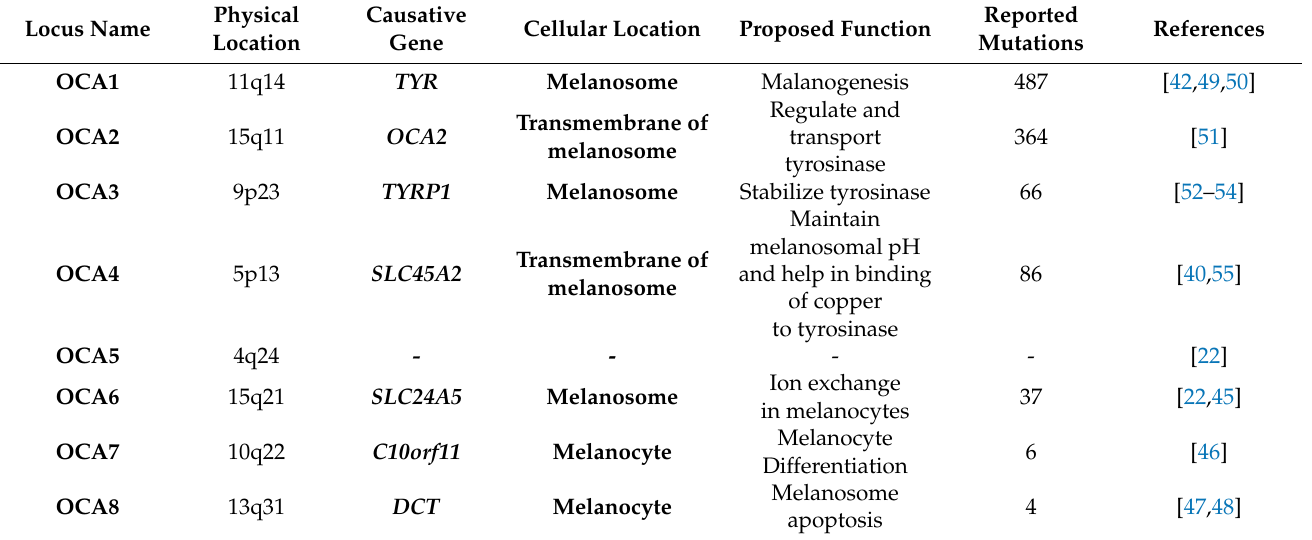
Table 1. Description of known genes and their cellular functions and localization in oculocutaneous